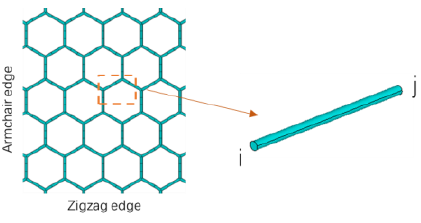
Figure 2. Finite element model (FEM) for graphene lattice.